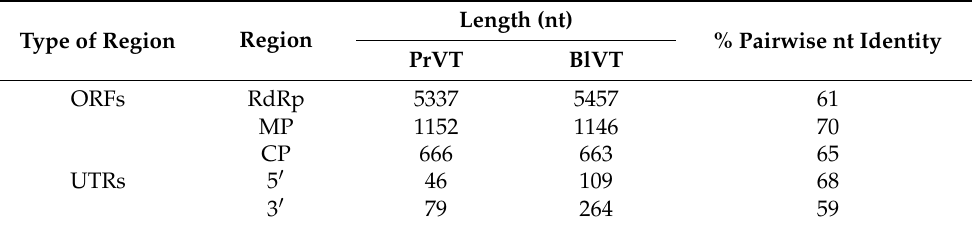
Betaflexiviridae using SDT indicated that BlVT shared the highest identity to the RdRp